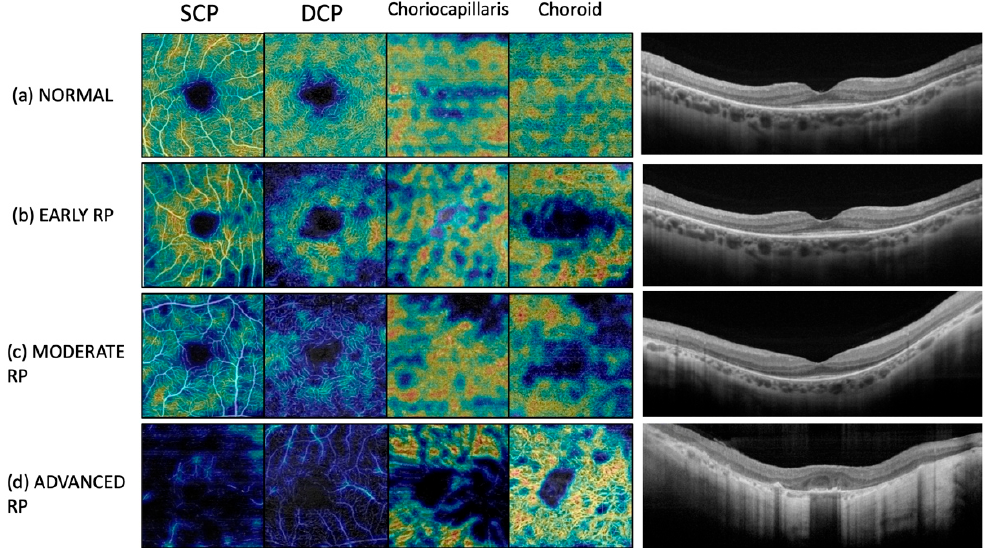
Figure 1. Vascular network differences between retinitis pigmentosa patients and a healthy subject in 3 mm × 3 mm OCTA scans at the ( a ) superficial capillary plexus (SCP), ( b ) deep capillary plexus (DCP), ( c ) choriocapillaris, and ( d ) choroid. In these angiograms, reduction in the vascular network density is recognizable. B ‐ scan OCT images at different disease stages are shown on the right. B ‐ scan OCT quantitative measurements were obtained for all the eyes included in the study. We manually measured central retinal thickness (CRT), subfoveal choroidal thick ‐ ness (CT), and CT at 1000 microns from the fovea in nasal and temporal sectors, using the